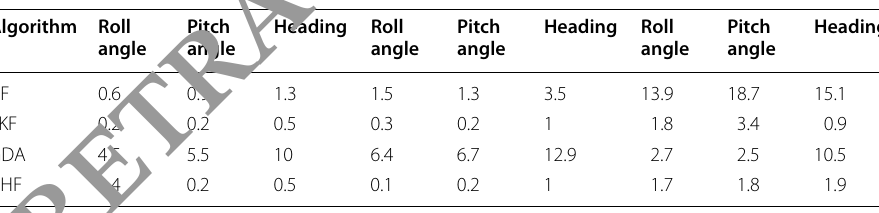
Table 2 Posture calculation results of each